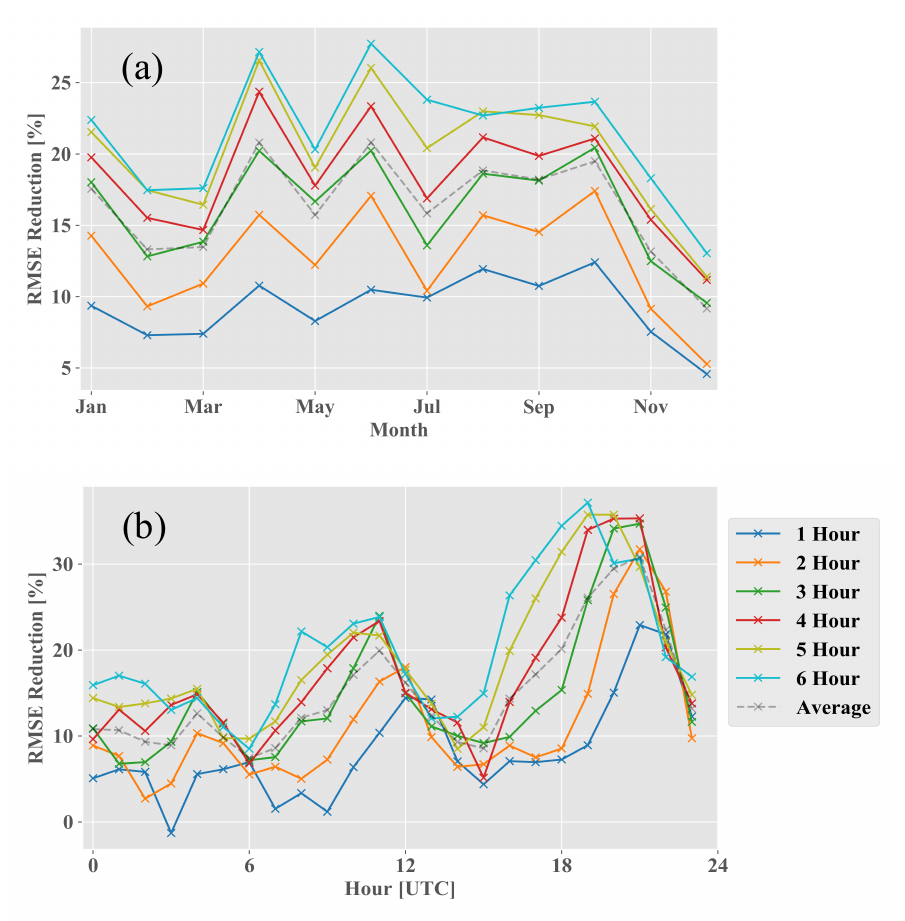
Figure 8. Similar to Figure 5 except data are taken from the SGP C1 site. RMSE reduction is partitioned by ( a ) month and ( b ) hour of the day (local time = UTC–0600